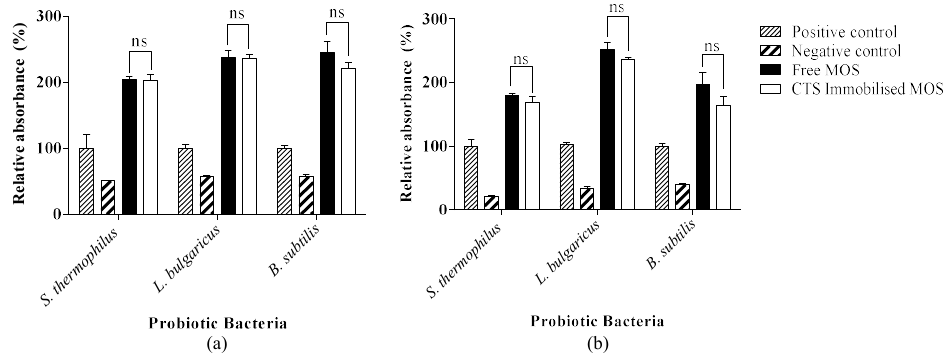
Figure 7. The evaluation of the prebiotic potential of SBM-generated sugars (0.155 mg/mL) produced using free and immobilised endo- β -1,4-mannanase by in vitro fermentation by probiotic bacteria ( Streptococcus thermophilus, Bacillus subtilis , and Lactobacillus bulgaricus ); ( a ) cell viability and ( b ) cell density. “ns” = Not significant.